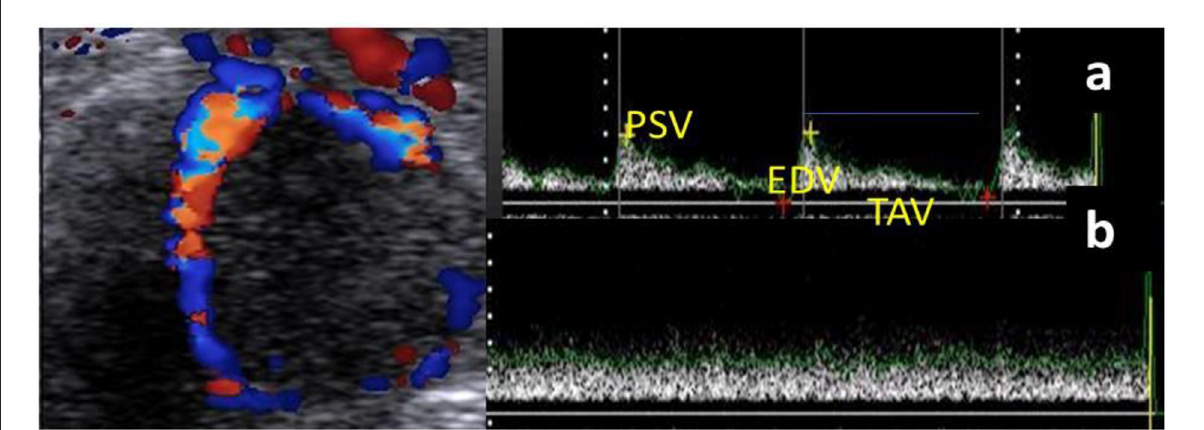
FIGURE1 Ultrasonogram revealed the mature corpus luteum (CL) with its spectral wave of both luteal artery (a) and luteal vein (b) blood flow velocities. N.B: Luteal artery waveform characterized by a complete cardiac cycle in from of peak systolic (PSV; cm/s) and end diastolic velocities (EDV; cm/s) with time average to make maximum velocity (TAV; cm/s), while the vein wave was characterized by absence of cardiac cycle without any spectral